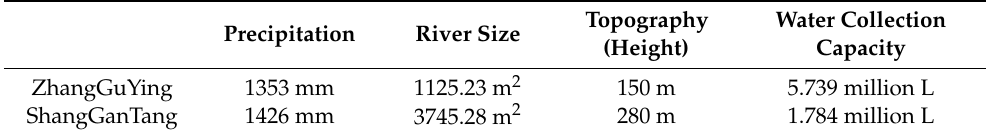
Table 4. The comparative analysis of two village. Precipitation River Size